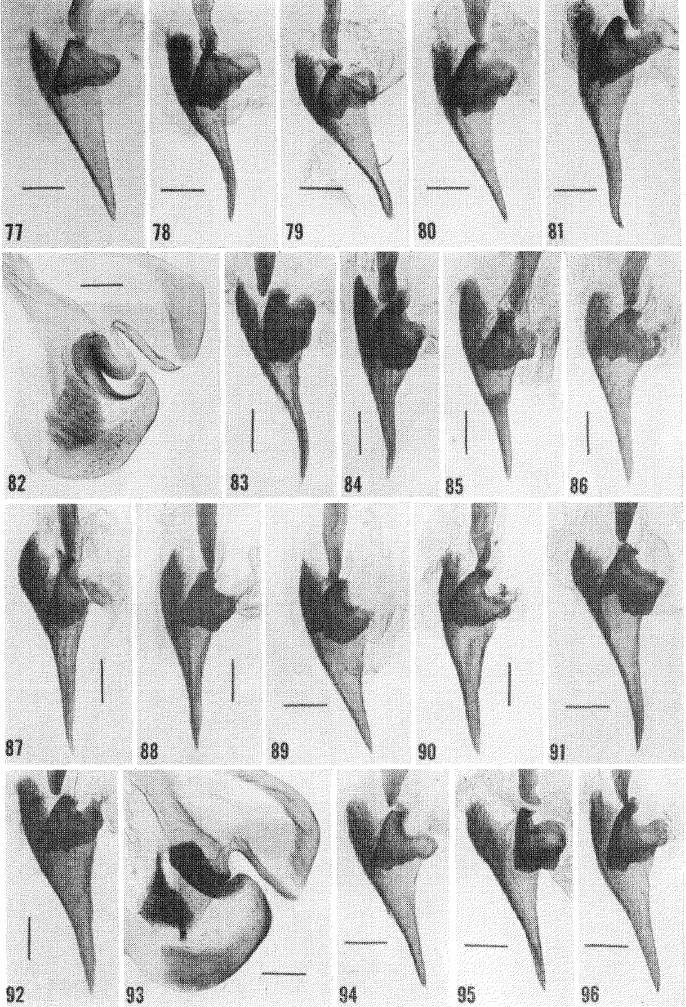
Figs. 77-96. Cockroach mle genitalia. Epilampra 7risea. 77. (169 USNM). Trinidad, British West Indies. 78. (93 USNM). Lelydorp, Surna- traweg, Surinam. 79. (94 USNM). Surinam. 80. (96 USNM). Popogai- mama Creek, Surinam. 81-82. (156 USNM). Blaneaflor, Beni, Bolivia. 83-93. (N). 83-85. Flores, Manaus, Brazil. 86. Adolpho Ducke Forestry Preserve, about 60 Km. from Manaus, Brazil. 87. Puraquequara, Rio Negro., Amazonas, Brazil. 88-89. Moura, Rio Negro, A_mazonas, Brazil. 90-93. Tapurueuara, Rio Negro, Amazonas, Brazil. 94. (107 USNM). 95. (108 USNM). At Plant Quarantine, Miami, Flori’a; with some bromeliads, possibly from Peru. 96. (65 USNM). At Miami, in plane, probably from South America. (all det. Roth). (scale 0.2